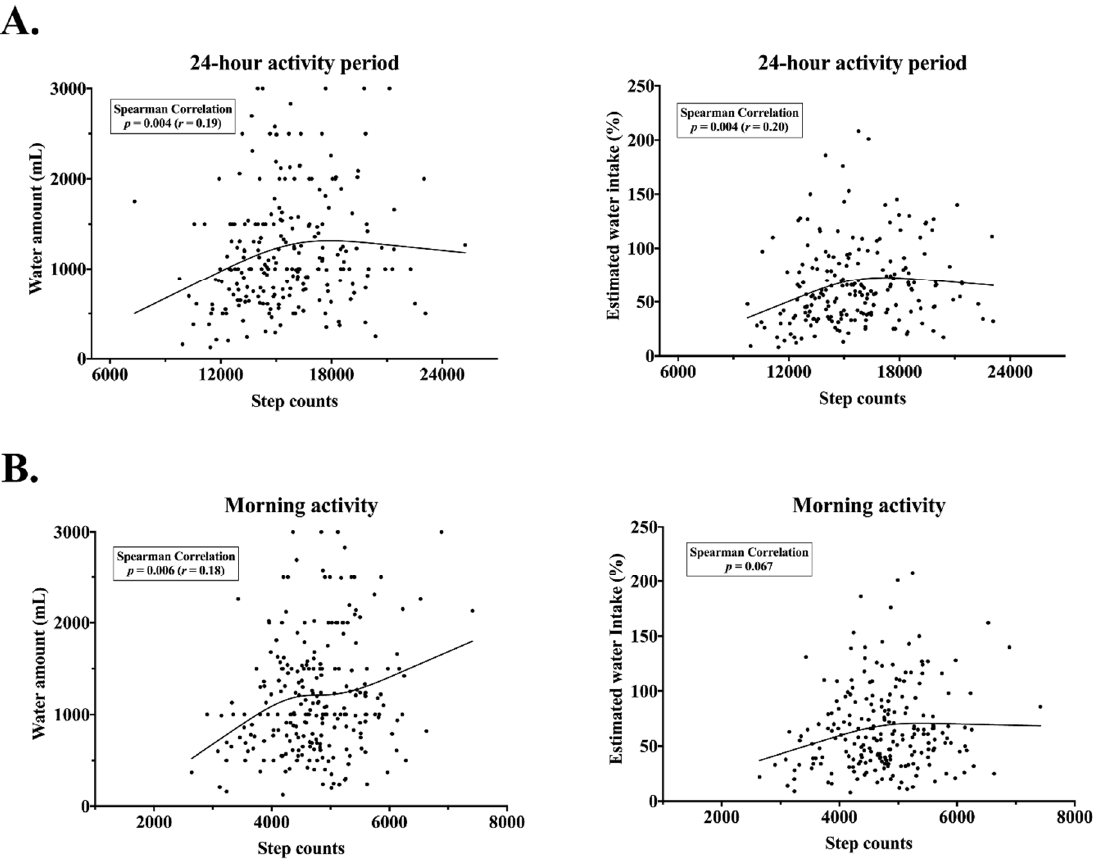
Figure 3. Scatterplots of a relationship between physical activity and water intake during a school day. ( A ) Non-linear positive association for step counts over the 24-h period and water amount ( n = 228) / percentage of individual estimated water intake in the morning ( n = 204) ( B ). Non-linear positive association for step counts throught the morning and water amount ( n = 244). No association for step counts throught the morning and percentage of individual estimated water intake ( n = 218).